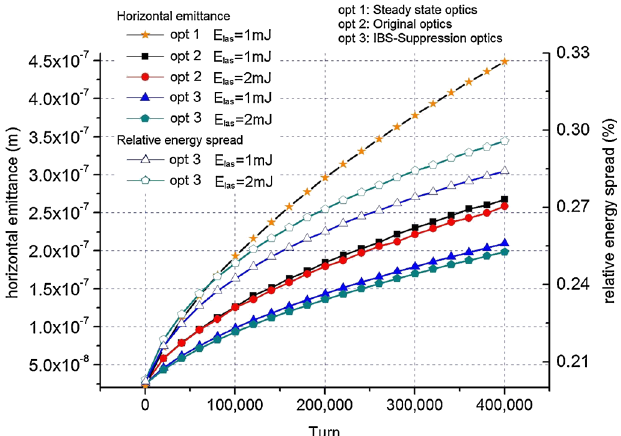
FIG. 6. (Color) The emittance growth and energy spread for the original optics [7], the IBS-suppression optics, and the steady mode optics [22]. As shown in the figure, CS plays as a cooling effect in the transverse direction while contributing to the growth of the energy spread.